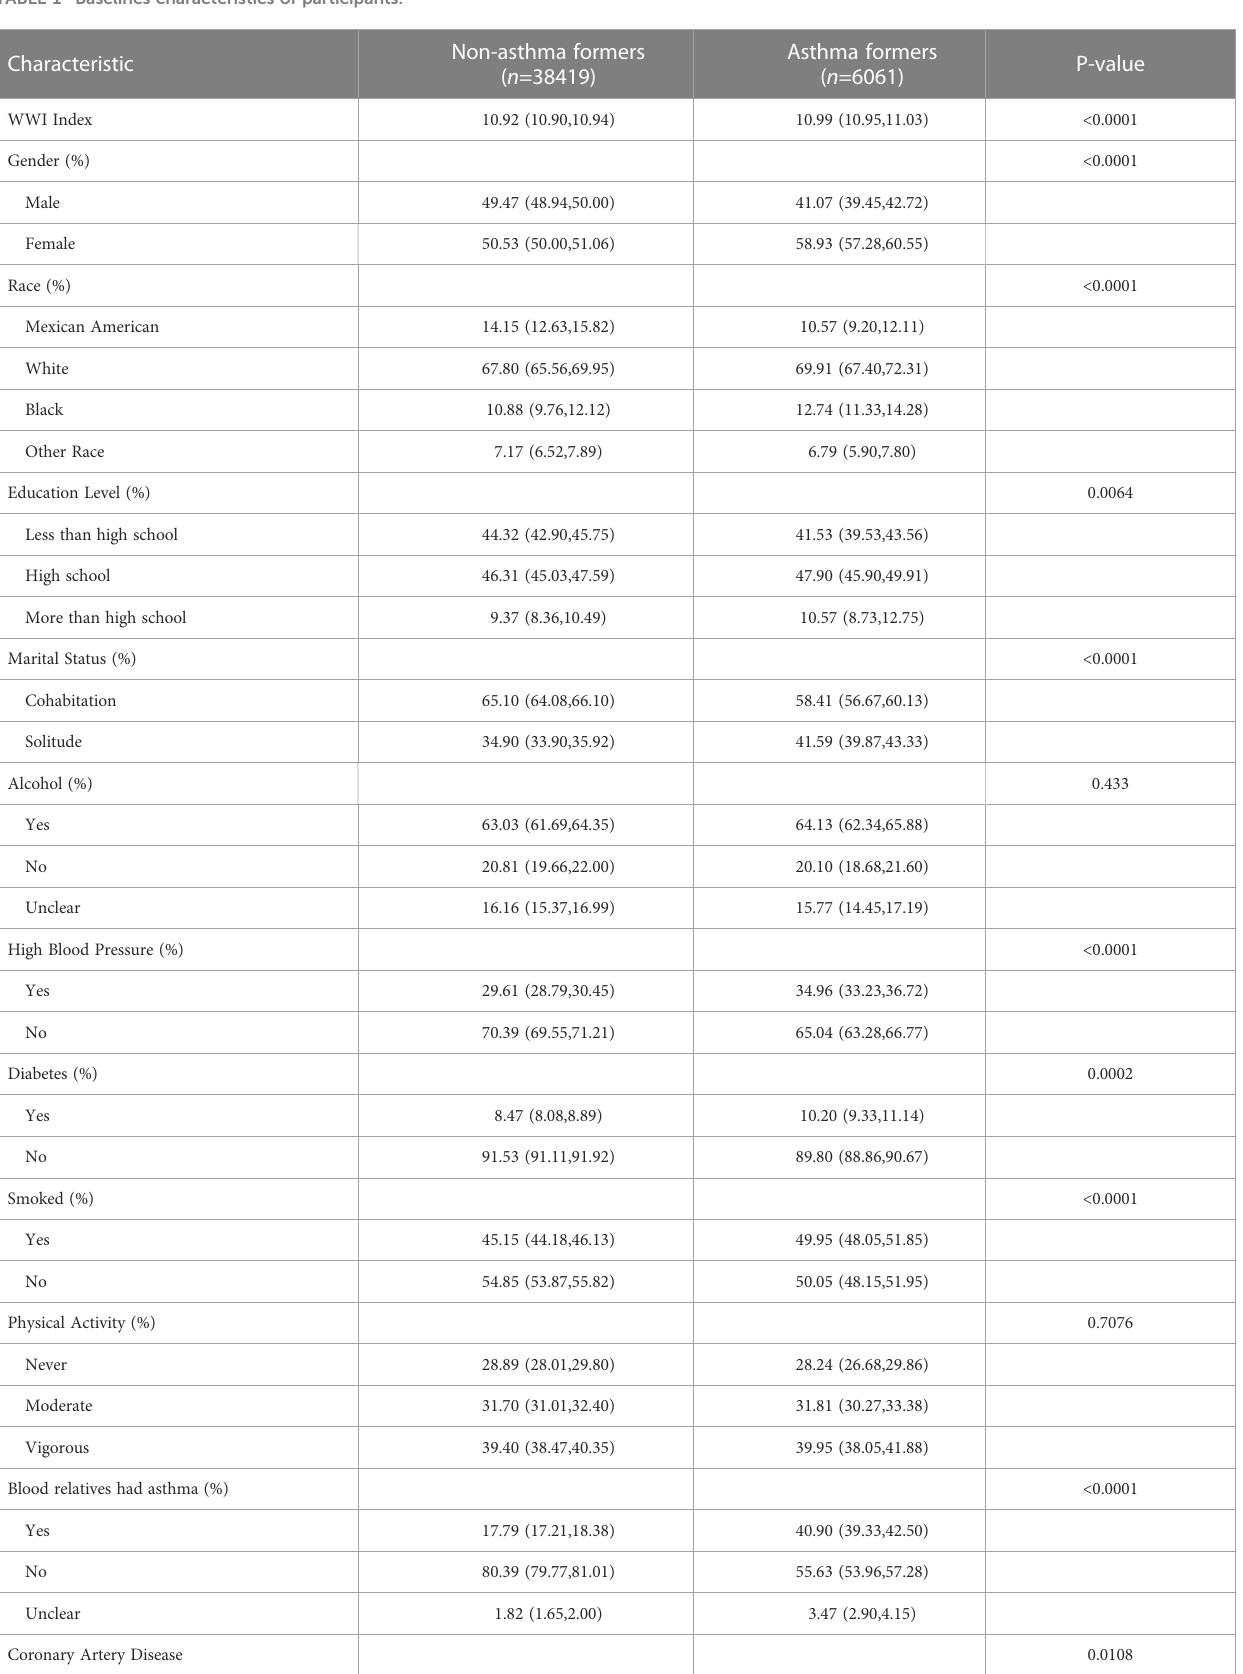
TABLE 1 Baselines characteristics of